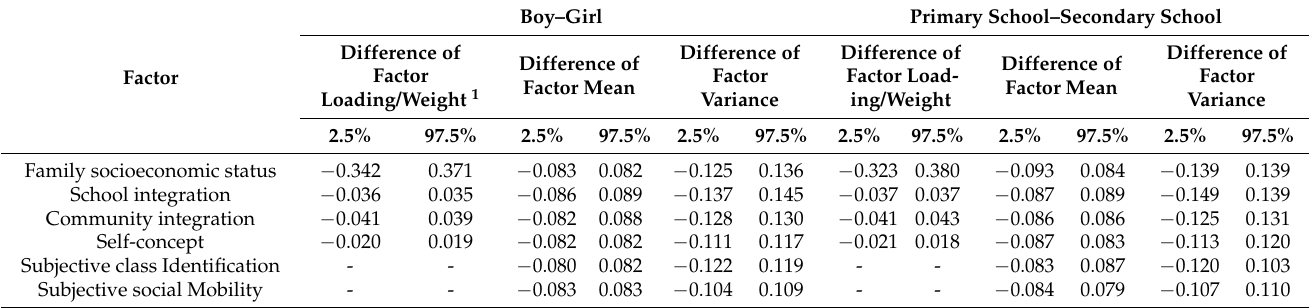
Table 8. Permutation group